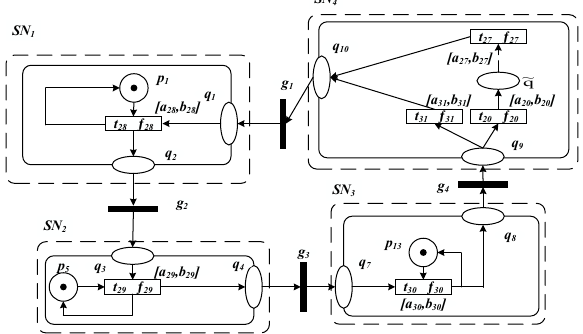
Figure 7. Σ (cid:2870) = {𝑁 (cid:2870) , 𝐹 (cid:2870) , 𝐺 (cid:2870) ,𝑀 (cid:2870) } obtained using the TQ-type internal subnet reduction rule. Figure 7. Σ 2 = { N 2 , F 2 , G 2 , M 2 } obtained using the TQ-type internal subnet reduction rule.